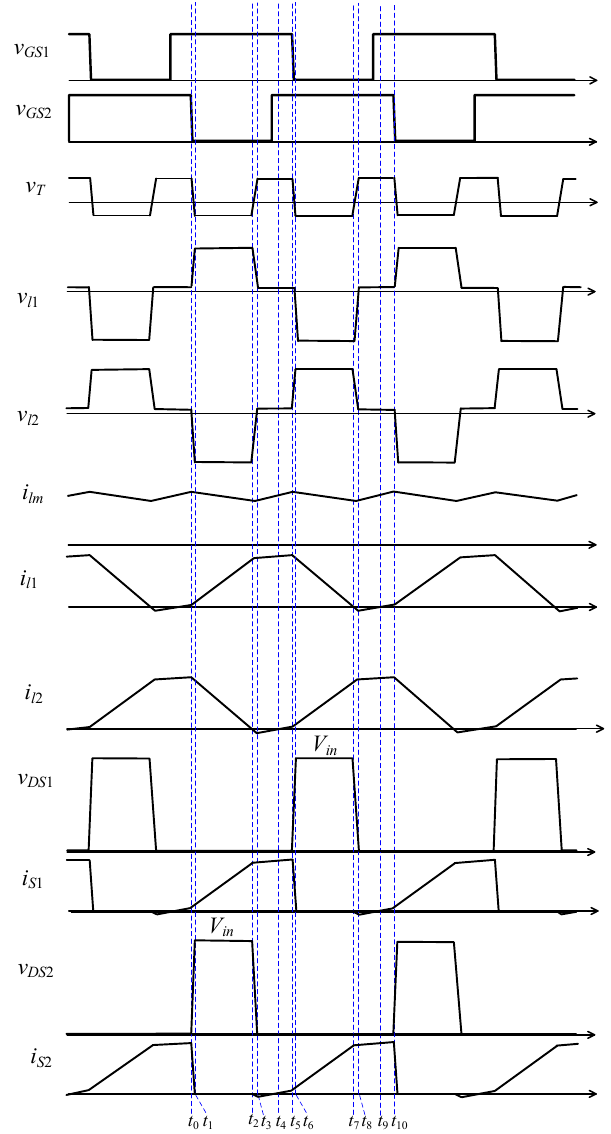
Figure 5. Conceptual waveforms of the main components.